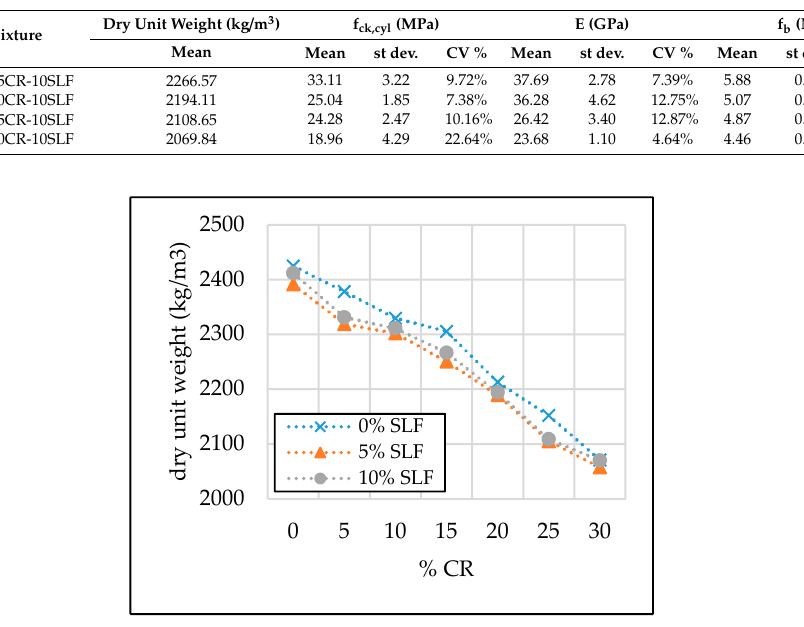
Figure 11. The effect of crumb rubber and silica fume on dry unit weight.